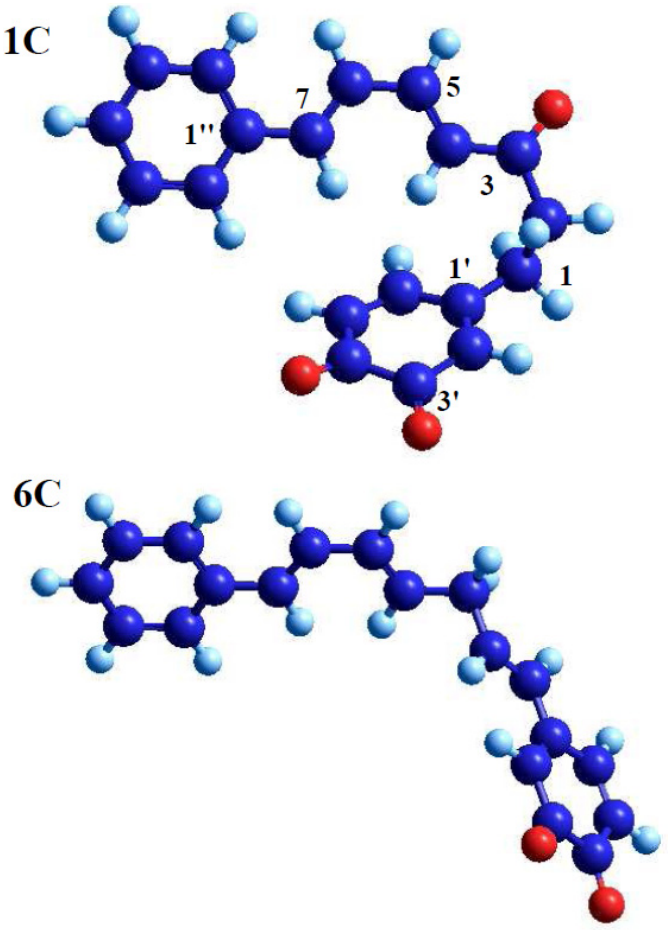
Figure 3. Diarylheptanoid 1c and 6c exemplify the two geometrical types of diarylheptanoids under study (the atom numbers in accordance with Figure 1 are shown for compound 1c ). Compound 1c is bent into a stacked geometry with a short distance between the diene carbons C-4/C-7 and the dienophile carbon atoms C-5'/C-6' and therefore seems able to undergo the Diels-Alder cyclization. The stretched geometry of compound 6c does not favor an intramolecular Diels-Alder